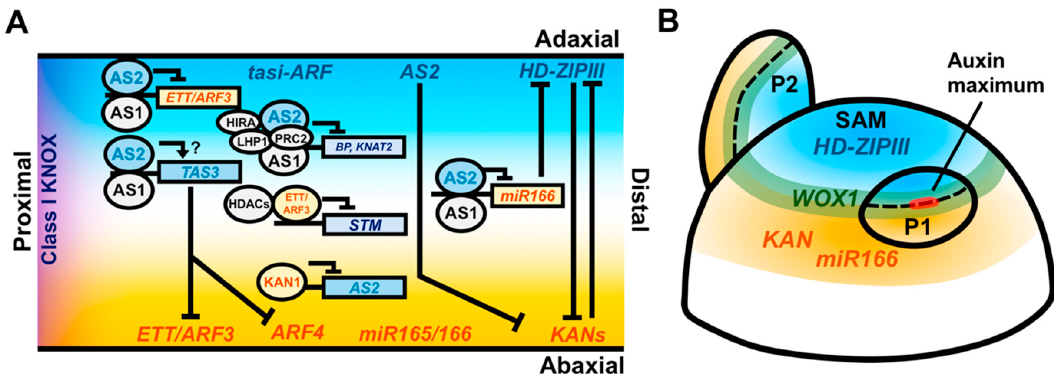
Figure 2. Coordination of adaxial–abaxial and proximodistal leaf patterning factors. ( A ) Longitudinal model cross-section of the leaf with adaxial factors labeled in cyan, abaxial factors labeled in orange, and proximal factors labeled in purple. AS2 and HD-ZIPIII transcripts accumulate in the adaxial domain of the leaf, while ETT/ARF3 , ARF4 , miR165/166, and KAN transcripts accumulate in the abaxial domain. miR165/166 and the mature ta-siARF RNAs are capable of moving intercellularly and repressing HD-ZIPIII and ETT/ARF3 postranscriptionally. HD-ZIPIII and KAN genetically antagonize one another and AS2 can genetically repress KAN . The AS1–AS2 complex recruits the HIRA protein and the PRC2/LHP1 complex to repress expression of Class I KNOX genes and also directly binds and represses the expression of ETT/ARF3 and miR166 in the adaxial portion of the leaf. AS1–AS2 binds TAS3 , which encodes the ta-siARF precursor transcript, possibly as a protective mechanism to exclude TAS3 -antagonizing transcription factors from accessing their promoter binding sites. The abaxial factor ETT/ARF3 directly represses the expression of the Class I KNOX gene STM by recruiting HDACs. KAN restricts AS2 expression to the adaxial domain via a direct repressive interaction. ( B ) Radially organized expression domains of patterning factors within the meristem may prepattern the adaxial–abaxial axis of the leaf. HD-ZIPIII genes are expressed centrally while KAN and miR166 are expressed peripherally. WOX1 expression occurs at the juxtaposition of these domains. The auxin response is restricted to the boundary region where auxin promotes outgrowth of the leaf primordium, retaining the prepatterned domains of gene expression during the establishment of the proximodistal leaf axis.